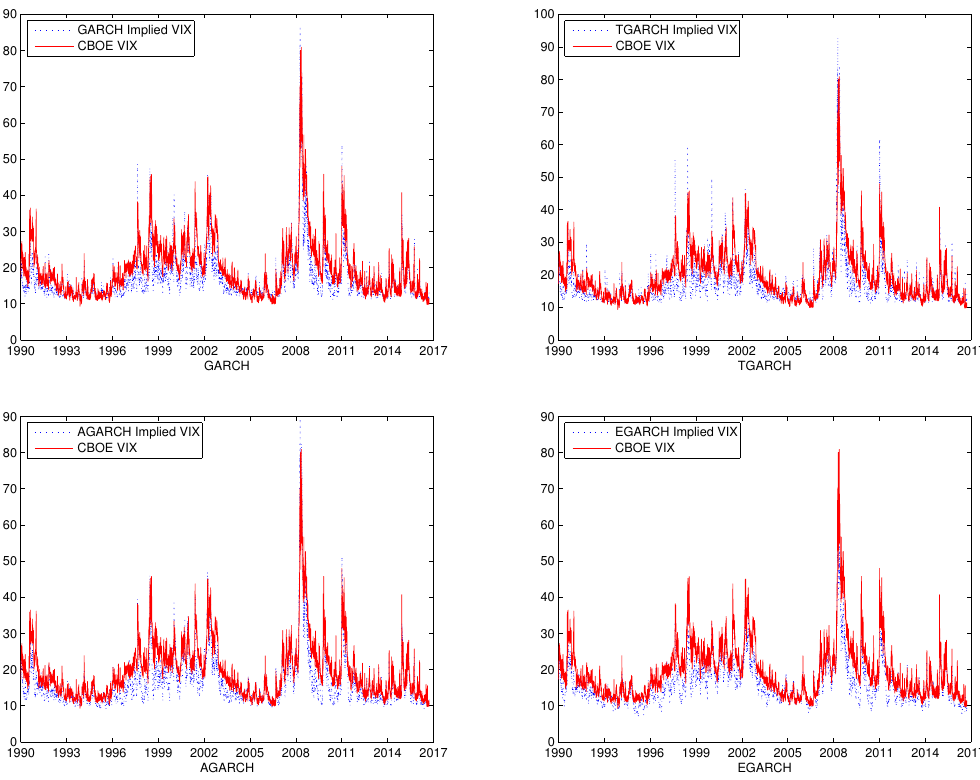
Figure 1. Comparison between CBOE VIX and implied VIX using returns data only for four GARCH models under the